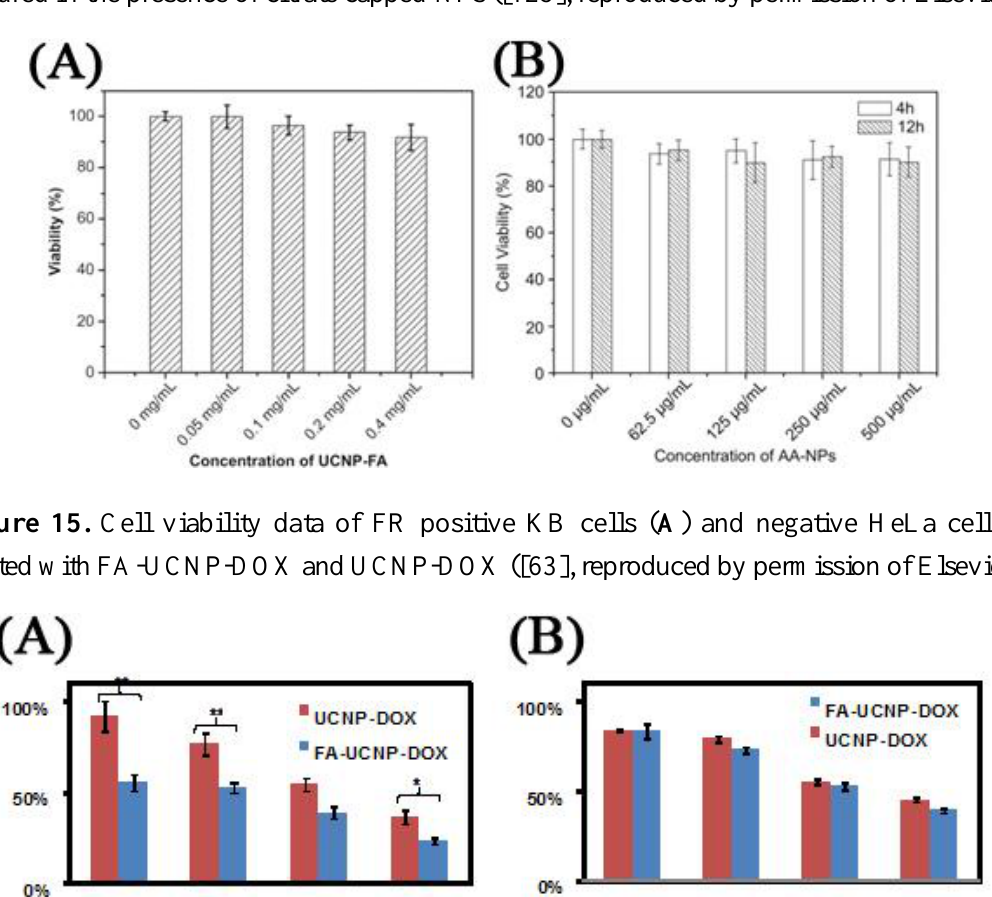
Figure 14. Left: Cell viability estimated by MTT proliferation tests for different incubation concentrations of: ( A ) HeLa cells incubated with Folic Acid-UCNPs [65]; ( B ) KB cells cultured in the presence of citrate capped-NPs ([125], reproduced by permission of Elsevier).